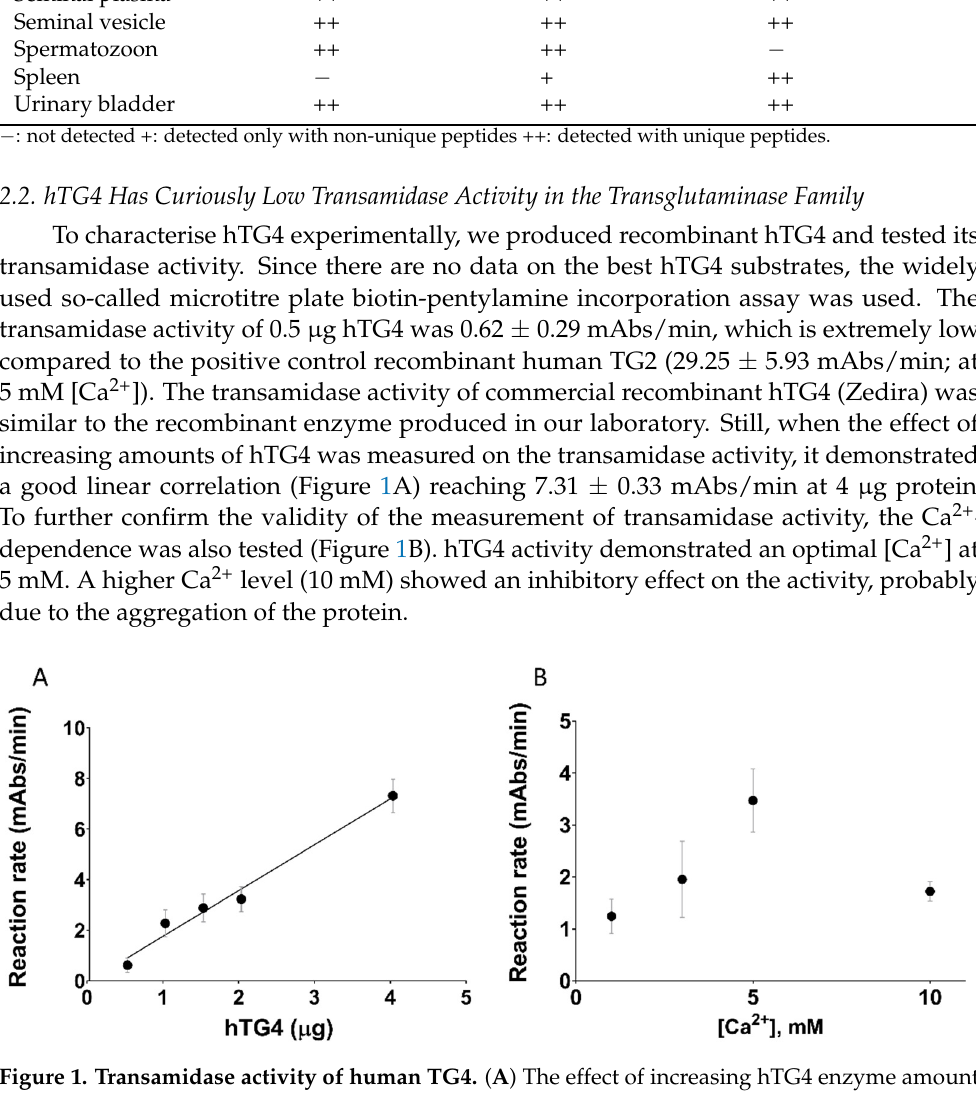
Figure 1. Transamidase activity of human TG4. ( A ) The effect of increasing hTG4 enzyme amount on the transamidase activity was measured in the presence of 0.5, 1, 1.5, 2 and 4 µg hTG4 protein and 5 mM Ca 2+ , at pH 8.5. ( B ) The calcium-dependence of hTG4 transamidase activity was tested between 1–10 mM calcium concentration range in the presence of 2.5 µg enzyme at pH 8.5. All data are represented as means with ± SD using Graph Pad Prism 8 from three independent measurements done in duplicates.